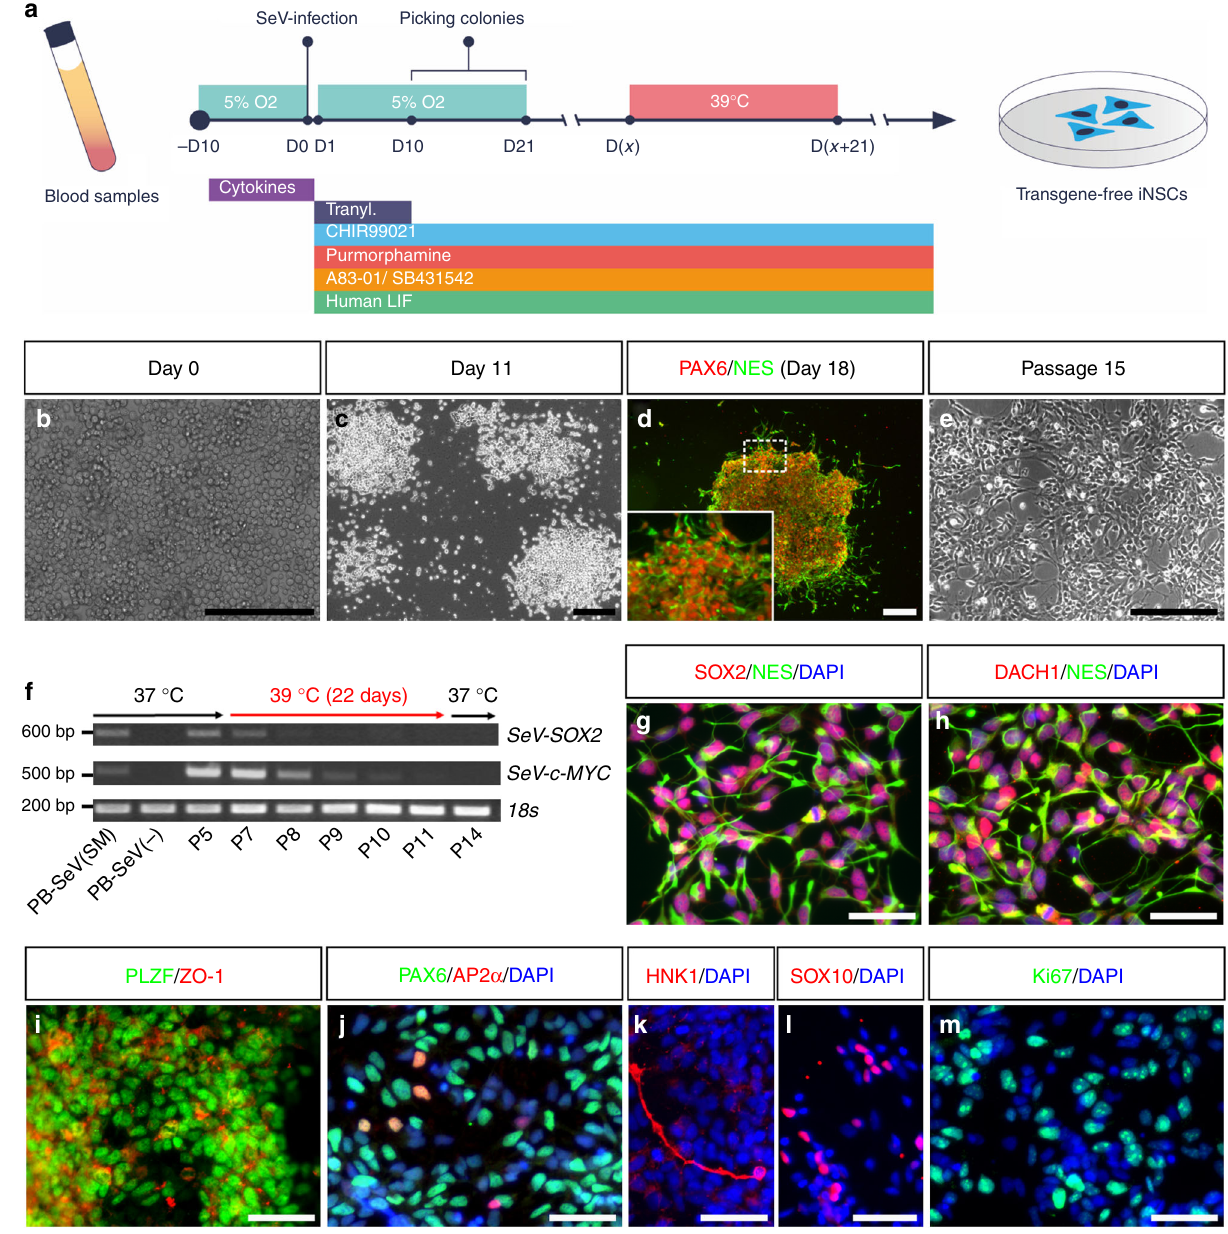
Fig. 1 Direct conversion of adult human PBCs into iNSCs. a Schematic representation of PB-iNSC generation. b – e Within 1 week after infection of PBCs ( b ), actively proliferating neuroepithelial colonies ( c ) immunopositive for early NSC markers PAX6 and NES ( d ) emerge, which can be further expanded to form stably self-renewing iNSCs ( e ). f RT-PCR con fi rms the fast decline of SeV-SOX2 and SeV-c-MYC expression during 39 °C incubation and the persistent absence of SeV genomes in iNSC cultures. g – l Transgene-free iNSCs express typical neural lineage markers, including early neuroectoderm and neural rosette markers SOX2 ( g ), NES ( g , h ), DACH1 ( h ), PLZF ( i ), ZO-1 ( i ), and PAX6 ( j ). A small fraction of cells is immunopositive for the neural crest markers AP2 α ( j , 2.0 ± 0.7%, mean ± s.d., n = 3), HNK1 ( k , 17.5 ± 8.3%, n = 3), and SOX10 ( l , 2.4 ± 0.3%, n = 3). m Proliferating iNSCs show prominent expression of the proliferation marker Ki67. P5 – P14: passage numbers; PB-SeV (SM): PBCs infected with SeV-SOX2 and SeV-c-MYC; PB-SeV ( − ): PBCs without infection. Scale bars: 200 μ m ( b – e ); 50 μ m ( g – m To study the electrophysiological properties of iNSC-derived vGLUT2, a marker of glutamatergic neurons (Fig. 2b). Differ- neurons, patch-clamp recordings were performed on neurons entiated cultures also contained neurons immunopositive for γ - differentiated for 8 – 12 weeks on primary mouse astrocytes 10 aminobutyric acid (GABA) or 5-hydroxytryptamine (5-HT), (Fig. 2f – l). Whole-cell current clamp measurements revealed the indicating the presence of GABAergic and serotonergic neurons, generation of multiple action potentials in 6 out of 7 neurons respectively (Fig. 2c, d). In addition to CNS neurons, PB-iNSCs upon depolarizing current injections (Fig. 2f). In response to spontaneously generated TUJ1 + neurons co-expressing BRN3A depolarizing voltage steps, 6 out of 6 iNSC-derived neurons and peripherin, markers typically expressed in PNS neurons generated fast and transient sodium-dependent inward currents (Fig. 2e). These results strongly indicate that PB-iNSCs can give and sustained potassium-dependent outward currents (Fig. 2g). rise to multiple neuronal subtypes of both CNS and PNS.